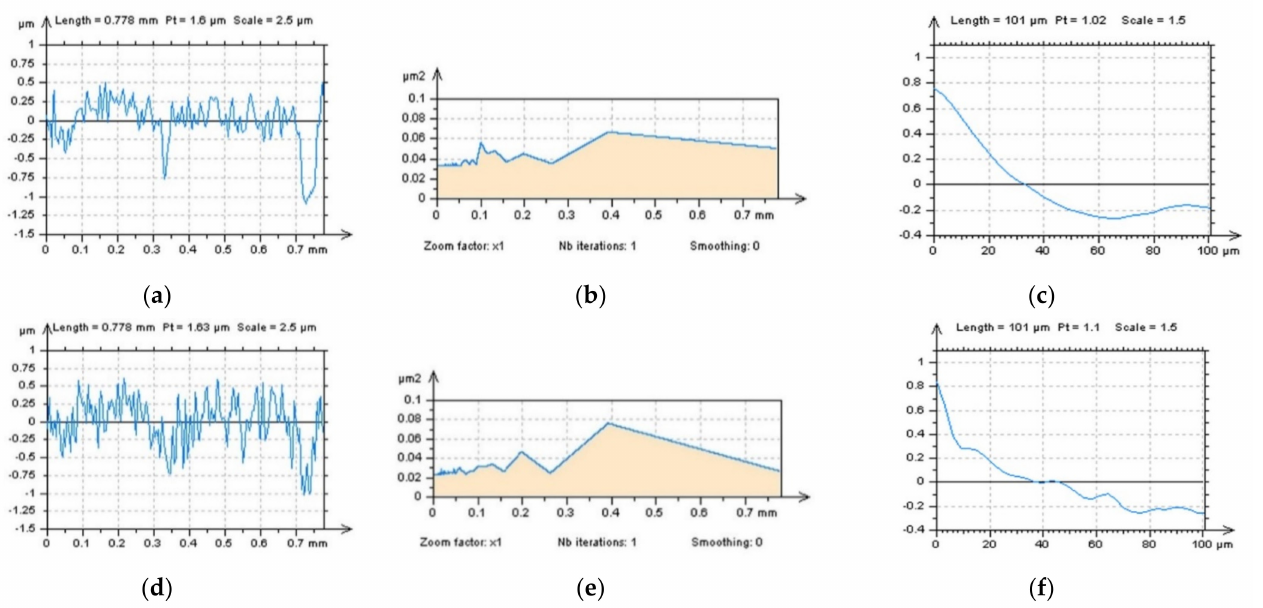
Figure 12. Profiles ( a , d ), their PSDs ( b , e ) and ACFs ( c , f ), respectively, were extracted from the raw measured plateau-honed surface containing oil pockets ( a – c ) and the same surface with modelled noise ( d – f